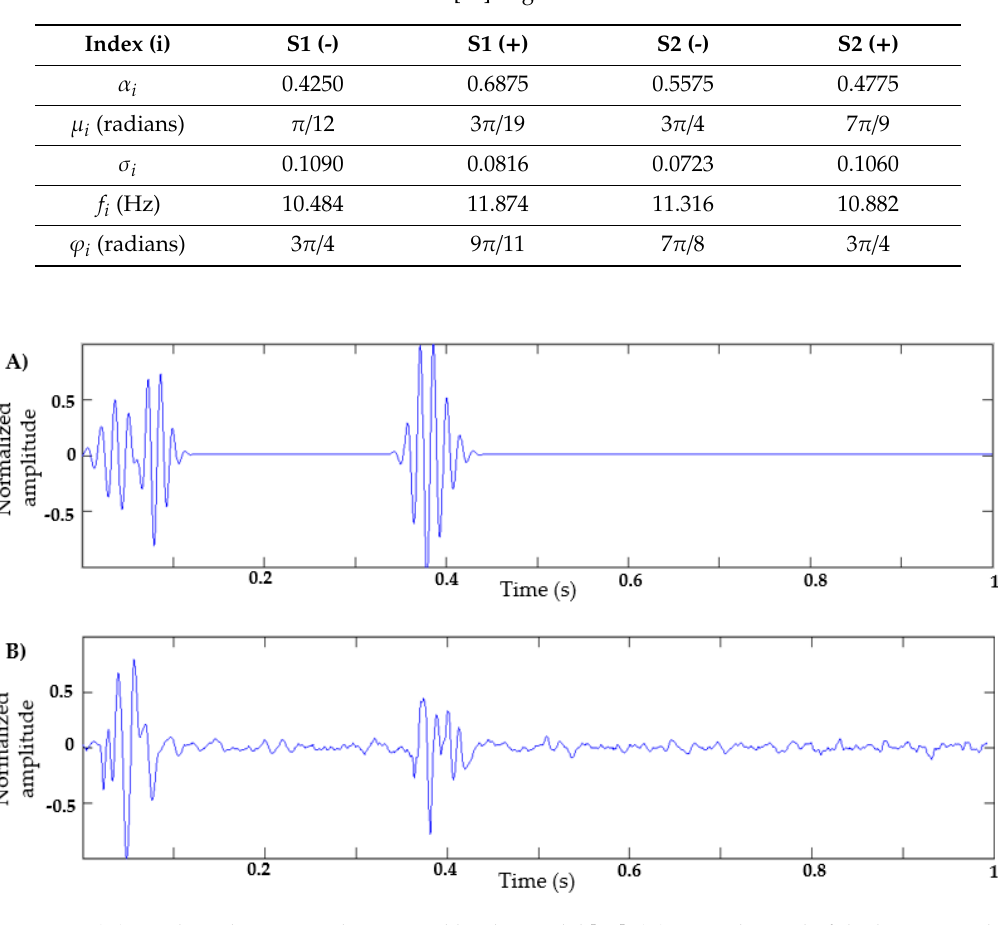
Figure 9. ( A ) Synthetic heart sound generated by the model [21]; ( B ) natural signal of the heart sound.